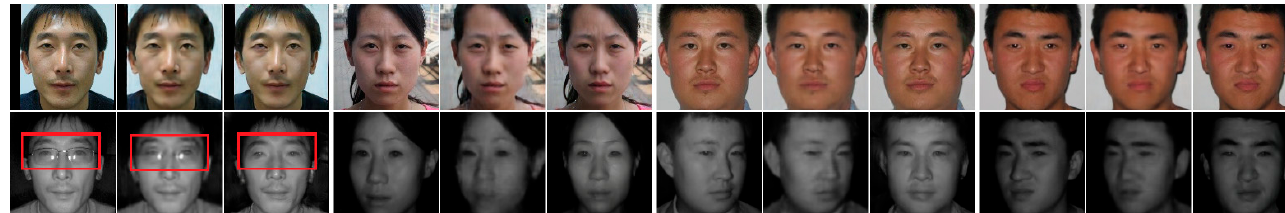
Figure 6. Reconstructed images of dual variational generation (DVG) (baseline) and our self-aligned dual generation (SADG) method. For each person, the first column is raw data, the second column is the result of DVG and the third column is the result of SADG. Our results were well-aligned.